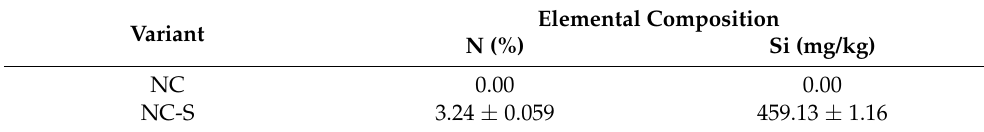
Table 4. Elemental composition of